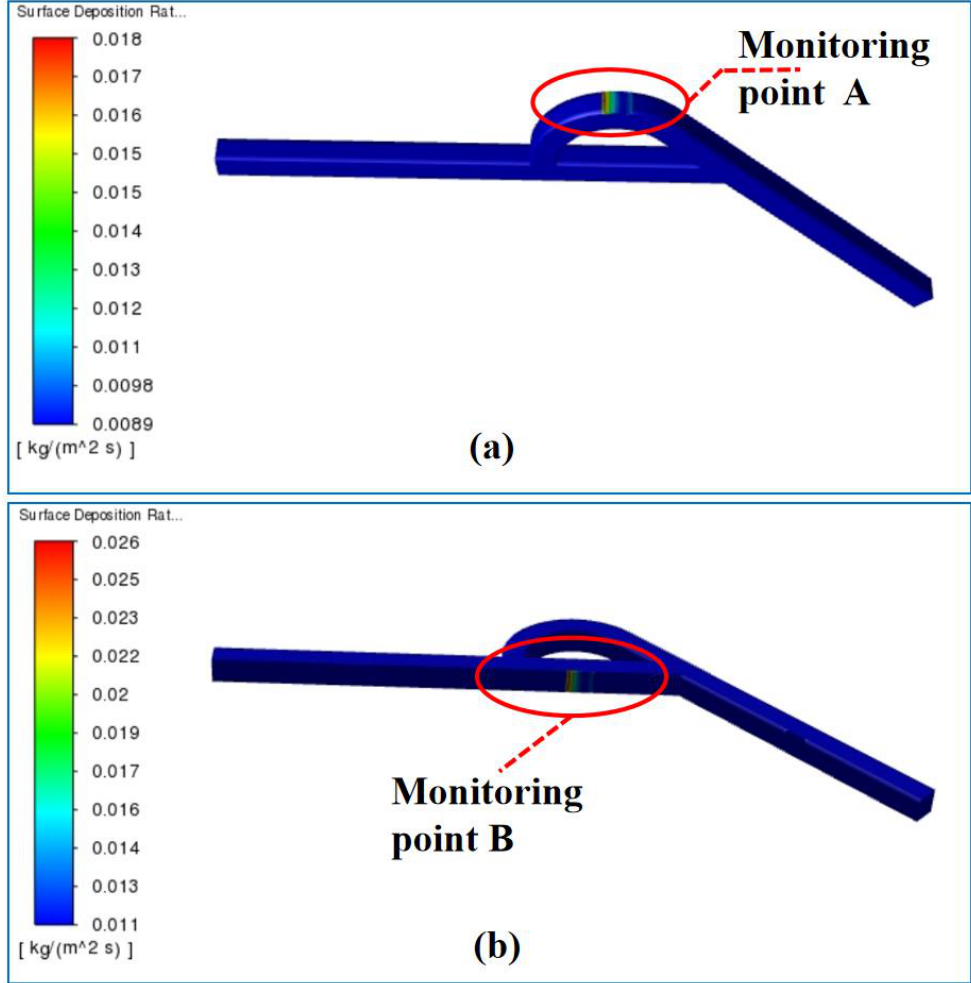
Figure 9. Contours for the graphene surface deposition rate with temperatures at monitoring points A and B : ( a ) Monitoring point A and ( b ) monitoring point B.